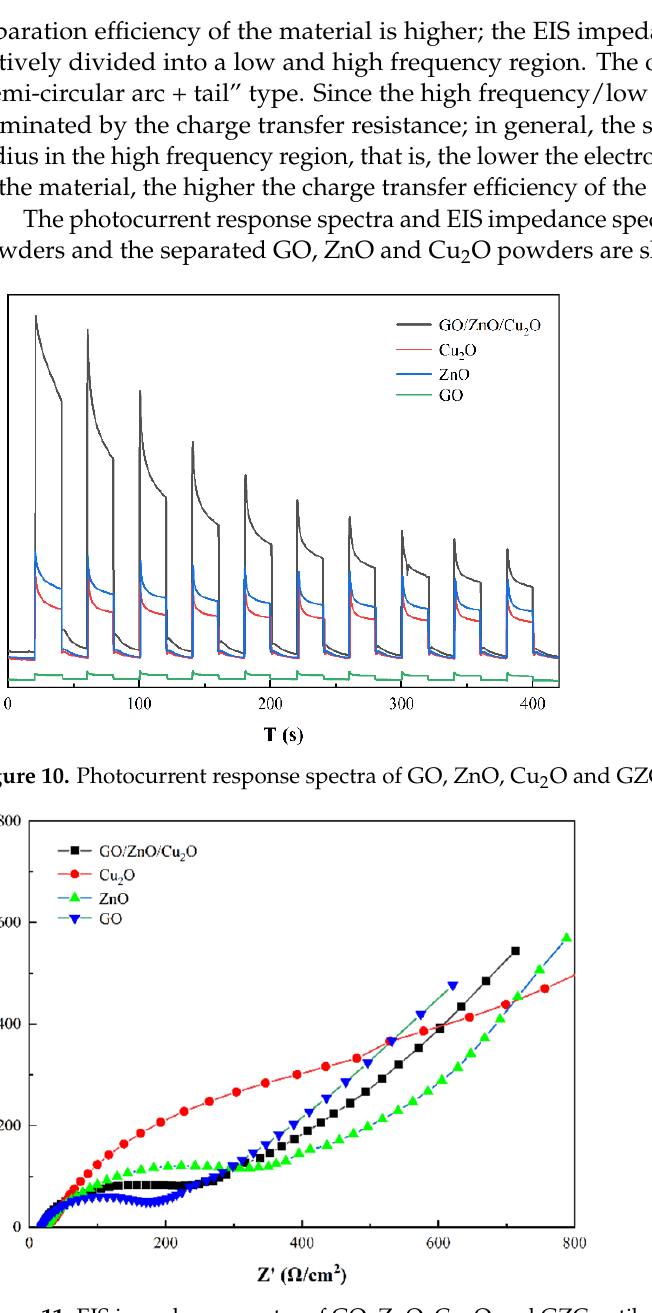
Figure 11. EIS impedance spectra of GO, ZnO, Cu 2 O and GZC antibacterial powder.